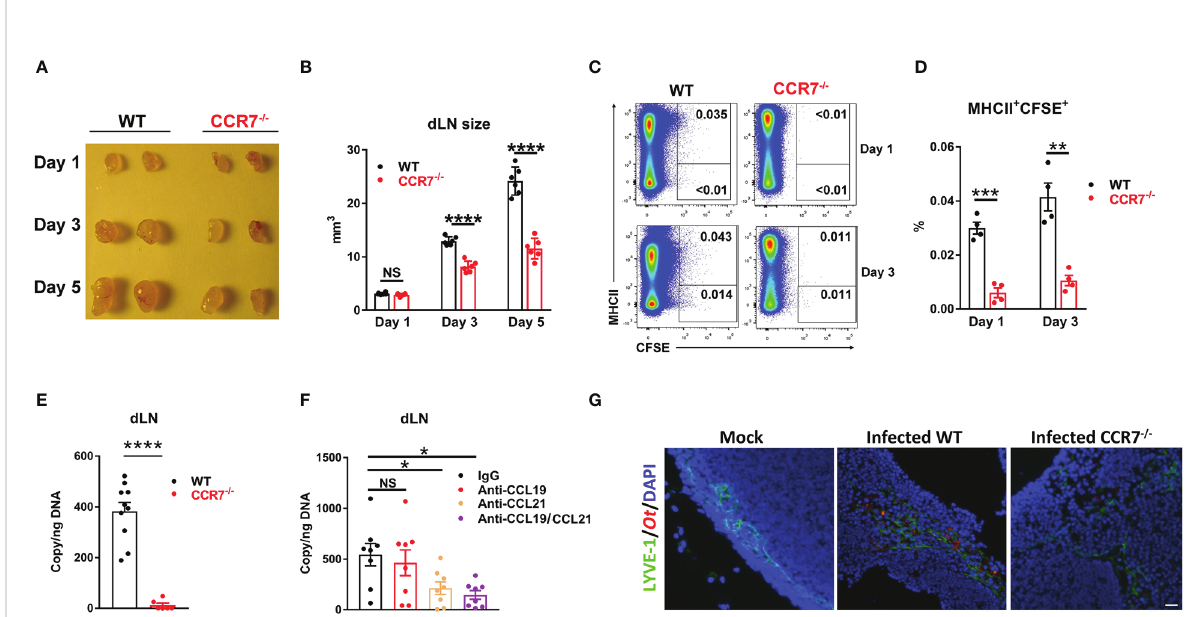
FIGURE 5 CCR7 knockout resulted in reduced bacterial dissemination into draining lymph nodes in mice. WT and CCR7 -/- mice (n=4-6/group) were i.d. infected with CFSE-labeled Ot (4×10 3 FFU) in the ears. (A) dLN were harvested at indicated time-points and (B) the sizes of dLN were quanti fi ed. (C, D) Single cell suspension was prepared from dLN at days 1 and 3, followed by the fl ow cytometric analysis of Ot -infected dendritic cells (de fi ned as MHCII + CFSE + ). (E) Bacterial loads in dLN of WT and CCR7 -/- mice (n=10/group) were quanti fi ed at day 3 by qPCR. (F) B6 WT mice (n=8/group) were i.d. injected with anti-CCL19 (2 µg), anti-CCL21 (2 µg) or both (2 µg/each, 4 µg total) at 1 day prior to infection. Goat IgG was used as a control or supplemented to reach equal amount of antibody (4 µg total) per injection. Mice were infected with CFSE-labeled Ot (4×10 3 FFU) in the ears and dLN were harvested at day 3 for bacterial load quanti fi cation. (G) dLN were collected from Ot -infected mice at day 5 and were processed for immuno fl uorescent staining. dLN tissue was stained for lymphatic endothelial cells (LYVE1, green), Orientia (TSA56, red) and DAPI (blue). Images were acquired by an Olympus IX73 inverted microscope. The scale bar is 20 µm. A one-way ANOVA with a Tukey ’ s multiple comparisons test is used for statistical analysis. A two-tailed Student ’ s t-test is used for comparison of two groups. *, p